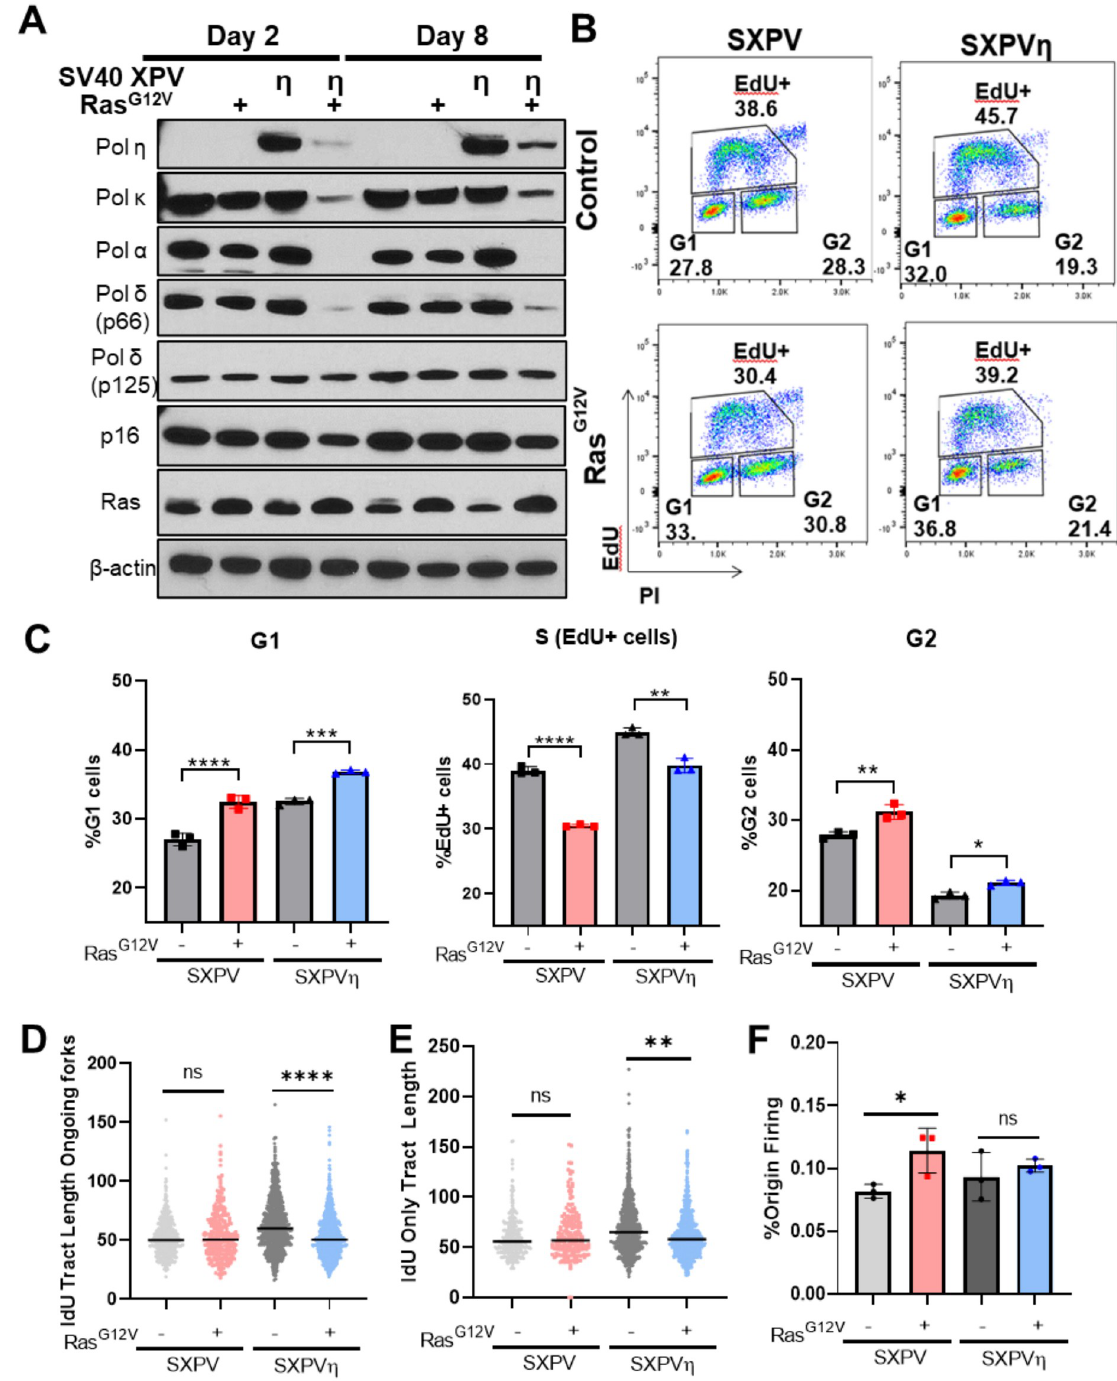
Fig 6. Differential oncogenic Ras G12V -induced DNA polymerase depletion is associated with altered replication fork dynamics. (A). Immunoblot analysis of SV40-transformed XPV cells (SXPV) and POLH -complemented SV40-transformed XPV cells (SXPV η ), infected with control or Ras G12V at Days 2 and 8. One of four biological replicates is shown. (B). Representative cell cycle analyses of SXPV/SXPV η cell populations infected with control vector or Ras G12V at Day 8. (C). Quantification of cell populations (B) from three biological replicates. (D). DNA fiber combing assay for ongoing (IdU-CldU) forks. Data represent IdU lengths of IdU-CldU tracts from two biological replicates. Statistical analysis was performed using Wilcoxon rank sum test with Holm’s post-hoc test. ���� p < 0.0001. n.s., not significant. (E). DNA fiber combing assay for terminated (IdU only) forks. Data represent IdU tract lengths from IdU only fiber of two biological replicates. Statistical analysis was performed using Wilcoxon rank sum test with Holm’s post-hoc test. �� p < 0.01. n.s., not significant. (F). DNA fiber